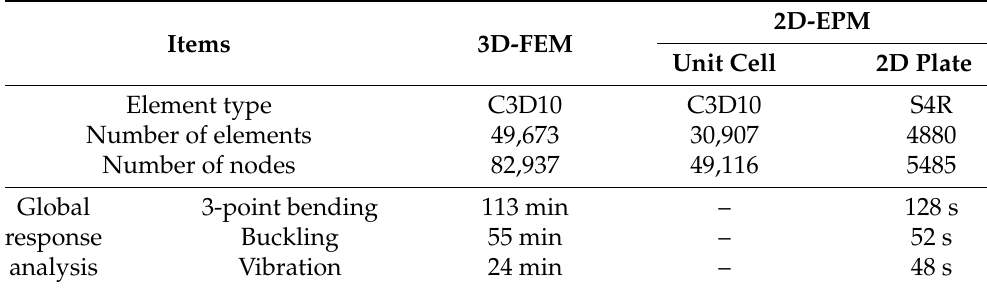
Table 7. Comparison of the calculation efficiencies between the different